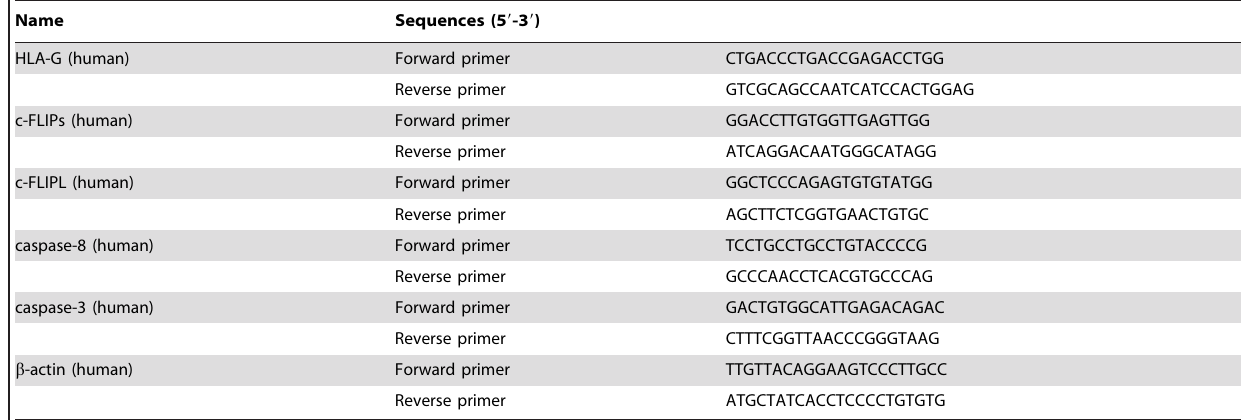
Table 1. Primer sequences and product